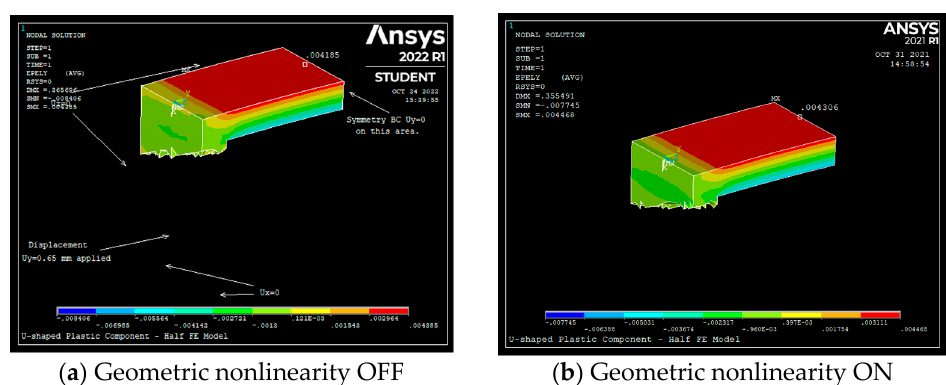
Figure 13. Tension strain ( ε y ) observed in ANSYS on the top surface of beam 2.